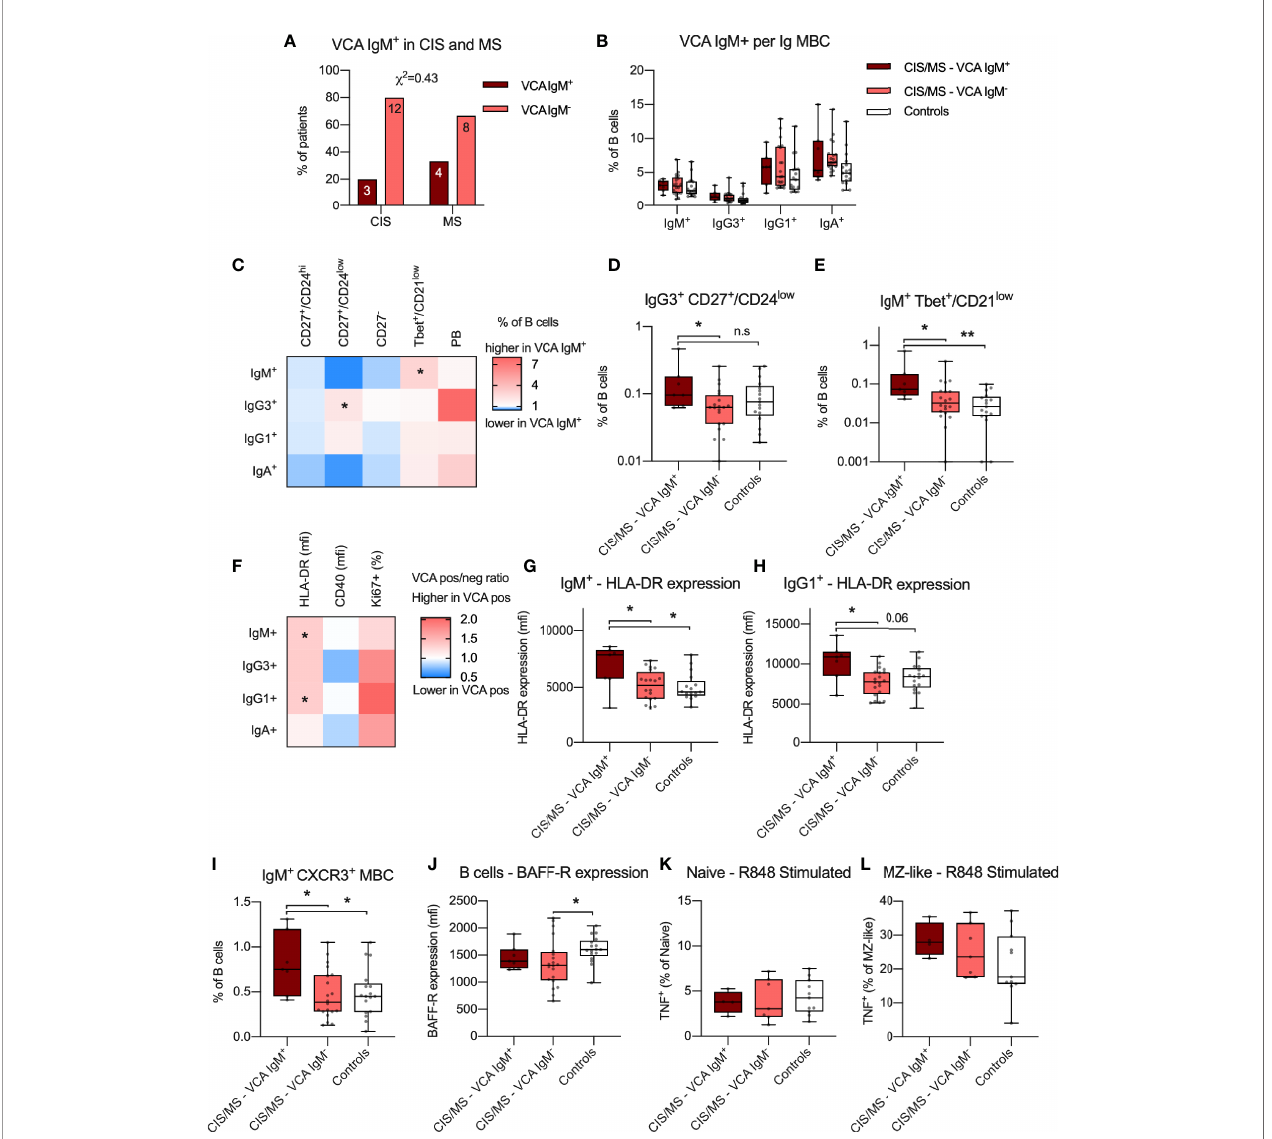
FIGURE 7 | (A) Proportion of VCA IgM + individuals with CIS or MS. Abundance of IgM + , IgG3 + , IgG1 + and IgA + MBC within the B cell population in VCA IgM + , VCA IgM - CIS/MS patients as well as controls. (C – E) Differences in mean ratio in VCA IgM + compared to VCA IgM - CIS/MS patients (C) for each MBC subset as well as raw data for signi fi cantly different subsets (D, E) . (F – H) Differences in mean ratio in VCA IgM + compared to VCA IgM - CIS/MS patients for expression of HLA-DR, CD40 as well as proportion of Ki67 + MBC within each MBC subset (F) as well as raw data for signi fi cantly different subsets (G, H) . (I) Proportion of IgM + CXCR3 + MBC in VCA IgM + , VCA IgM - and controls. (J) Expression of BAFF-R on BAFF-R + B cells in VCA IgM + and VCA IgM - CIS/MS and controls. (K, L) Proportion of TNF + Naive (K) and MZ-like (L) B cells following R848 stimulation in VCA IgM + and VCA IgM - CIS/MS patients and controls. Data in (A) are displayed as